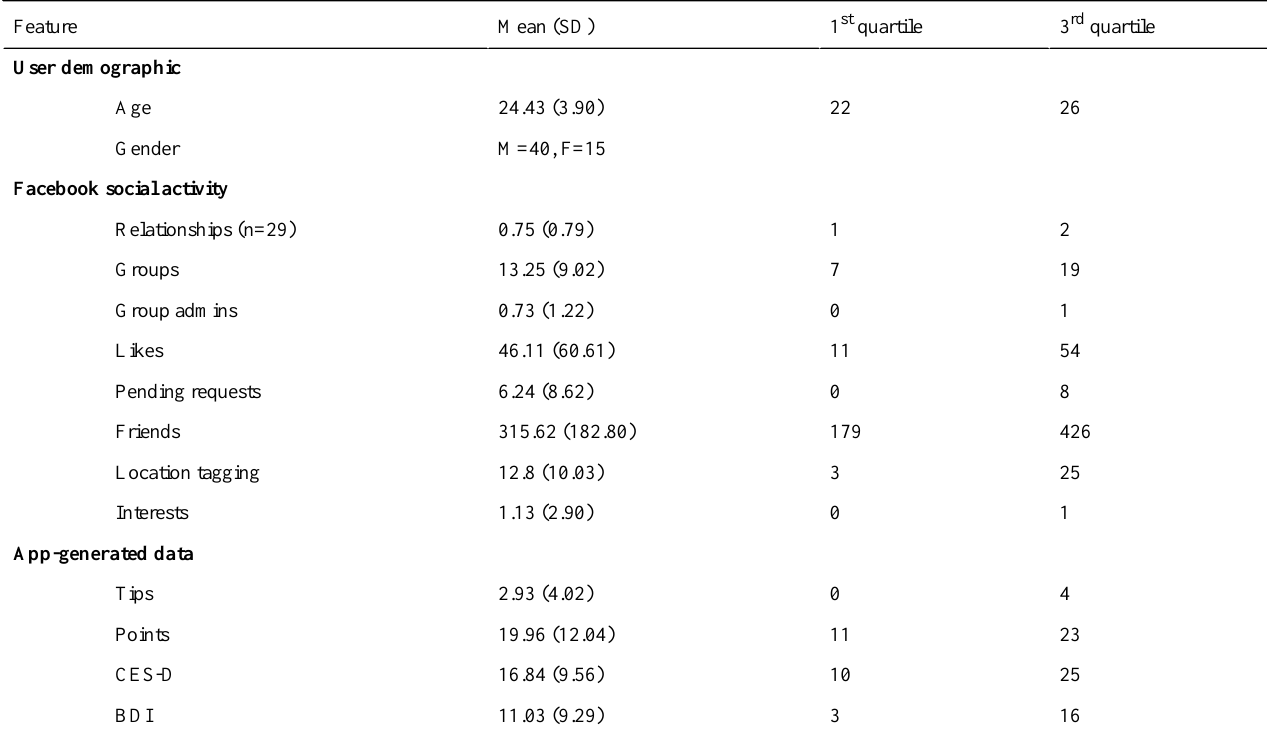
Table 2. Mean values of participants’Facebook social activity and app features (N=55).